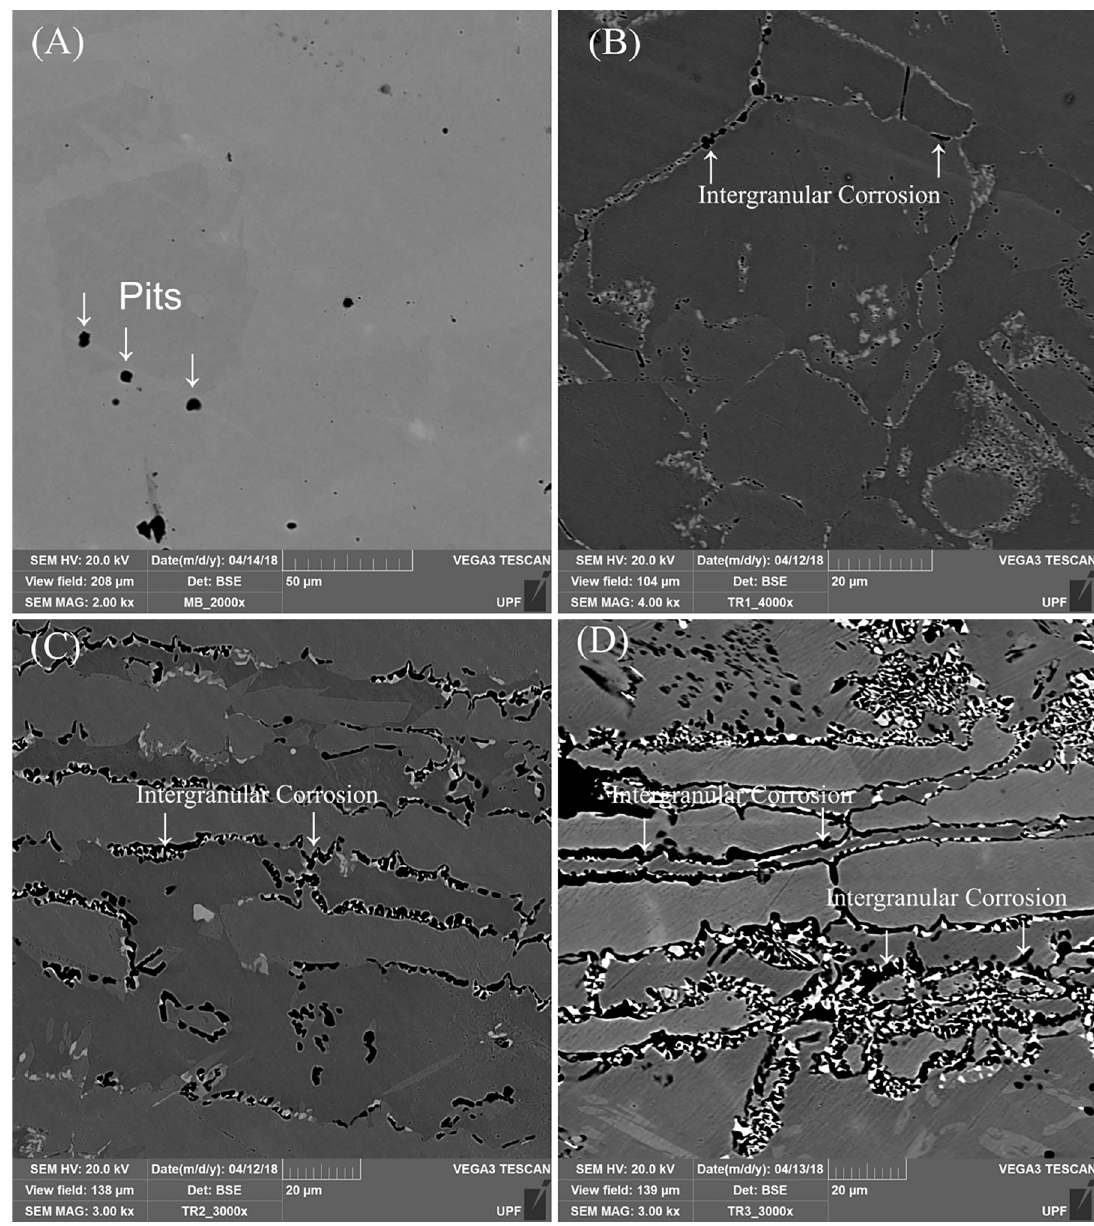
Figure 10. Surfaces after the polarisation test for ageing at 830 ºC for different times. As-received, A) 30 minutes, B) 90 minutes, and C) 180